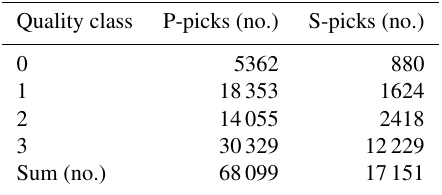
Table B1. Distribution of the picks and their quality classes after implementation of the automatic picking algorithms for the event list created by national catalogs. Quality